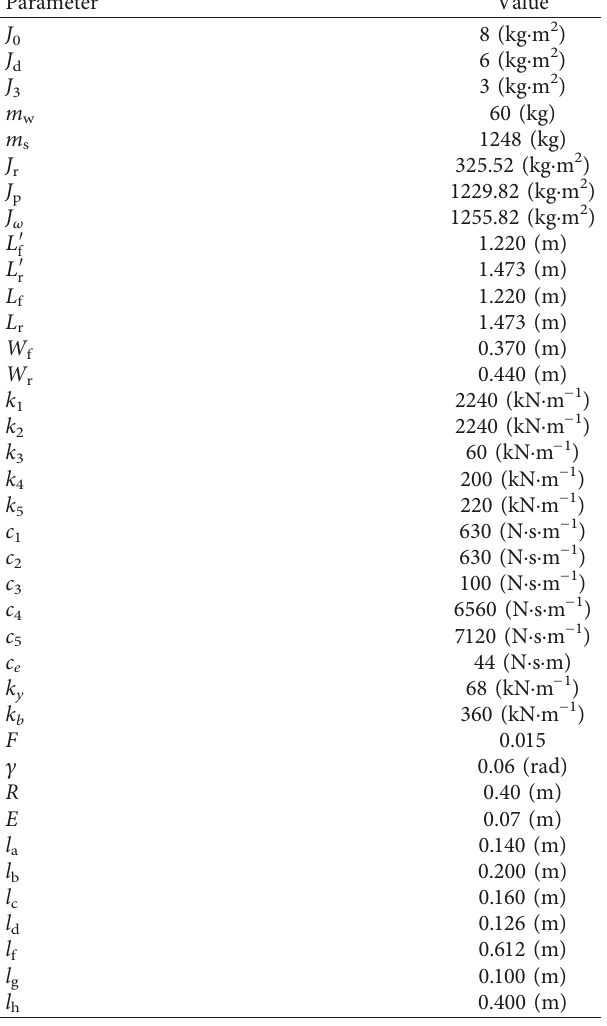
Table 2: Values of the parameters of vehicle shimmy.